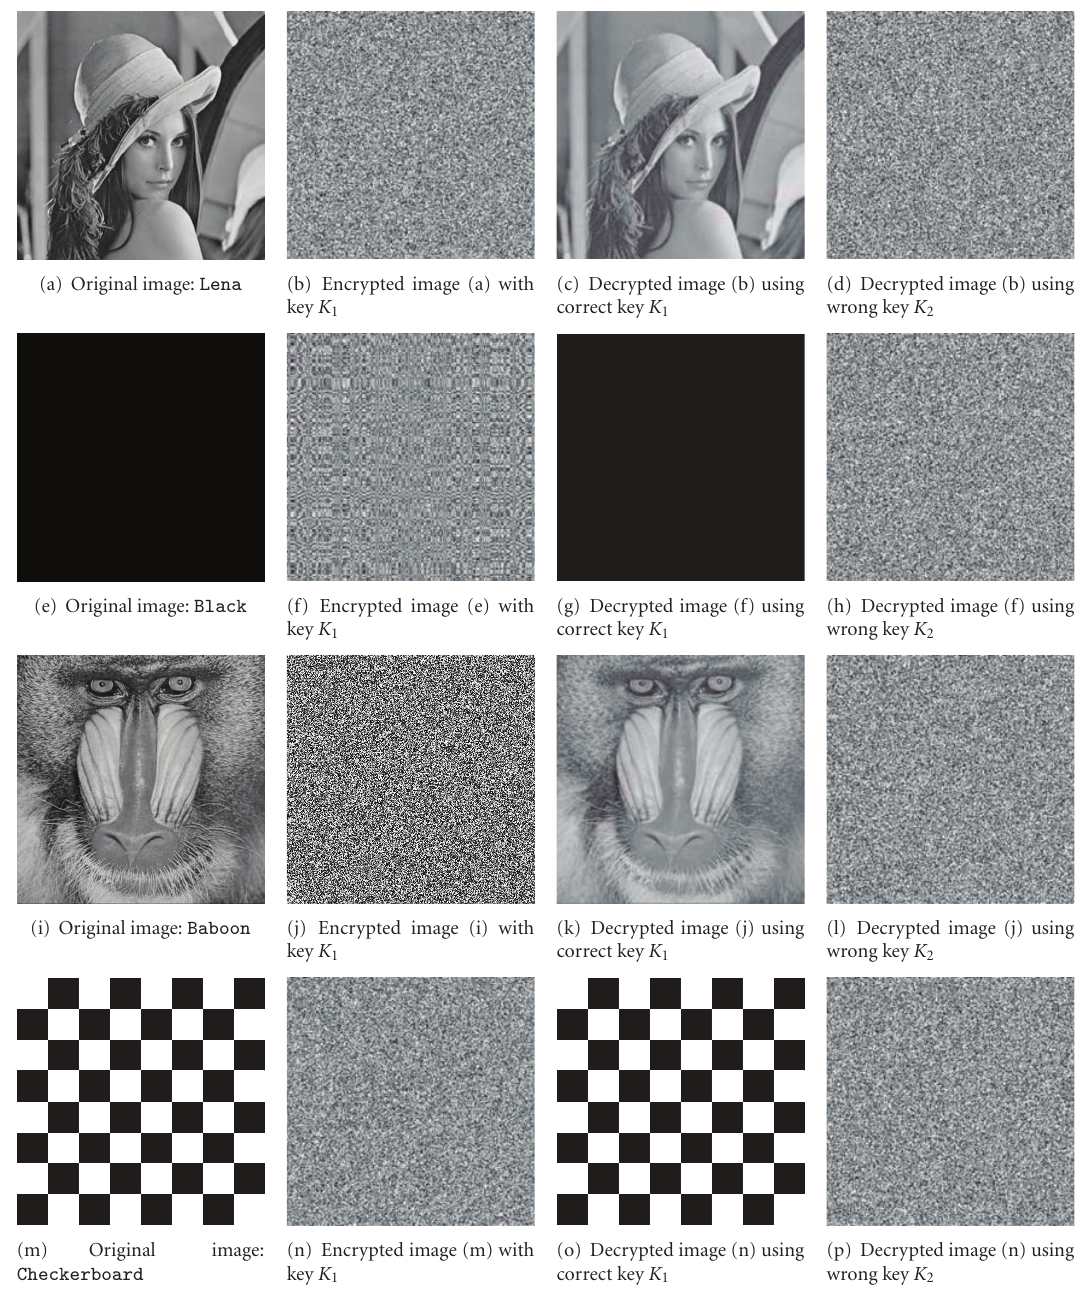
Figure 3: Key sensibility for image decryption using the proposed